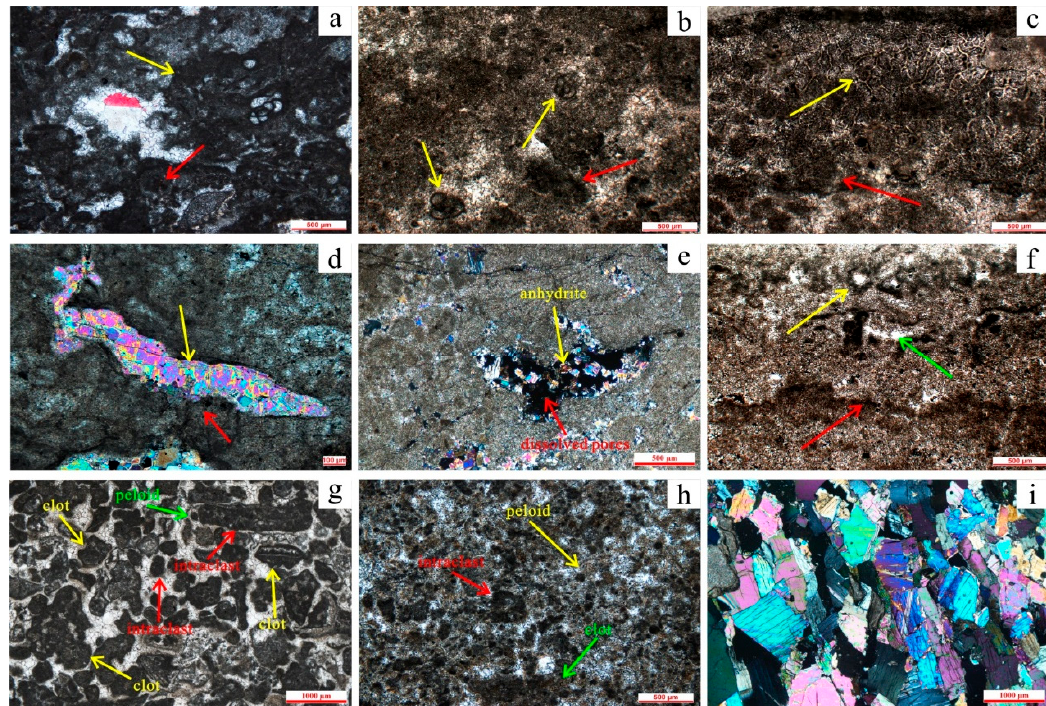
Figure 4. Microscopic characteristics of lithofacies types in the Leikoupo Formation. ( a ) Two kinds of clots in thrombolites: The clot composed of uniform dolomicrite (yellow arrow), and the clot bond of peloids (red arrow), T 2 l 43 , Yangshen-1 well, 6199.50 m; ( b ) Miliolinid foraminifera (yellow arrow) and microbial clots (red arrow), T 2 l 43 , Pengzhou-103 well, 6022.14 m; ( c ) Girvanella (yellow arrow) of cyanobacterium and microbial clots (red arrow), T 2 l 43 , Pengzhou-115 well, 6316.00 m; ( d ) Anhydrite fully filling in the original pores (yellow arrow) and microbial clots (red yellow), T 2 l 43 , Xinshen-1 well, 5628.80 m; ( e ) Residual anhydrite with irregular edge in dissolved pores, T 2 l 43 , Tongshen-1 well, 5850.22 m; ( f ) Two kinds of laminations in stromatolites: The lamination made up of dolomicrite (red arrow), and the lamination composed of peloids and clots (yellow arrow), and the fenestral pores can also be found (green arrow), T 2 l 43 , Yishen-1 well, 5891.28 m; ( g ) Three types of grains in in facies F, intraclast (red arrow), clot (yellow arrow) and peloid (green arrow), T 2 l 43 , Yangshen-1 well, 6119.98 m; ( h ) Three types of grains in facies G, intraclast (red arrow), peloid (yellow arrow) and clot (green arrow), T 2 l 43 , Yangshen-1 well, 6235.90 m; ( i ) Anhydrite in facies H, medium to fine crystal, T 2 l 42 , Longshen-1 well, 6720.10 m.